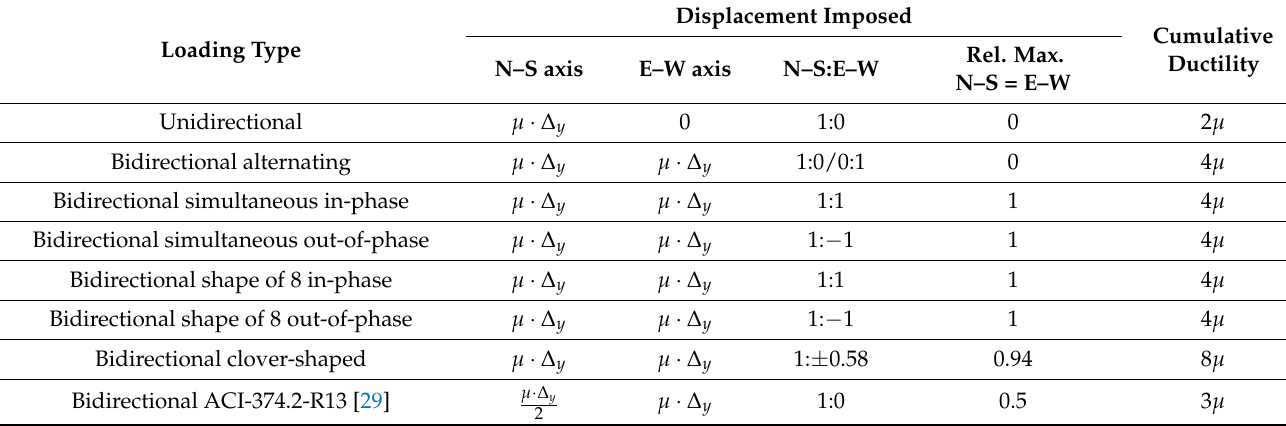
Table 1. Imposed displacement and cumulative ductility in one cycling set at a given displacement